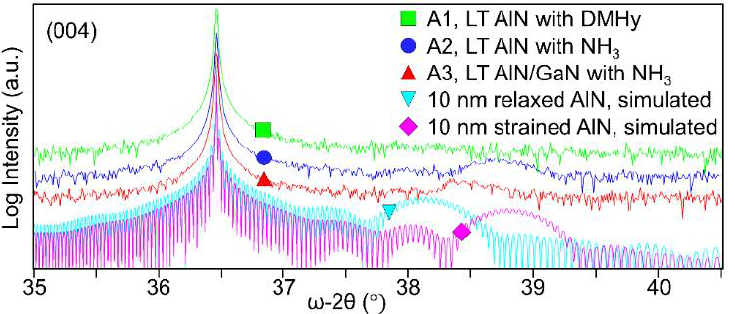
Figure 6. XRD ω -2 θ scans of the (004) GaN peak for samples A1, A2, and A3. Simulated scans are also shown for 10 nm of either fully relaxed or fully strained AlN on